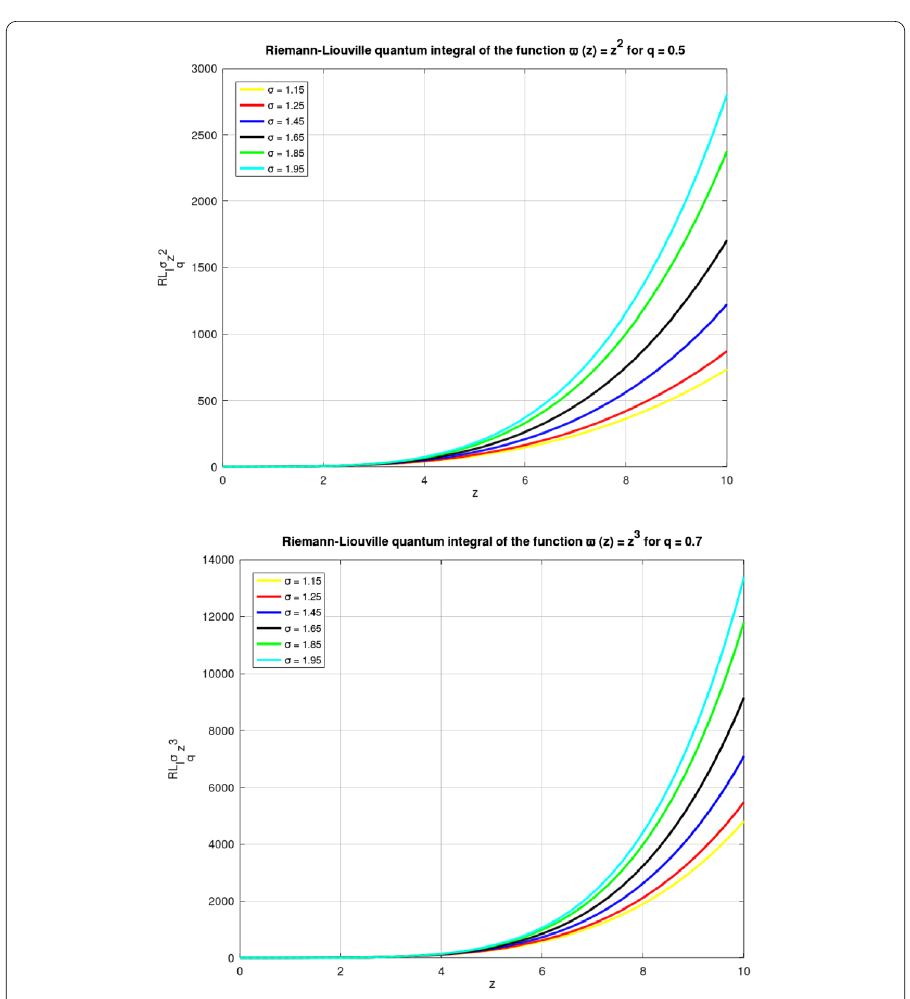
Figure 1 The Riemann–Liouville quantum integral of (cid:3) ( z ) = z 2 , z 3 for q =